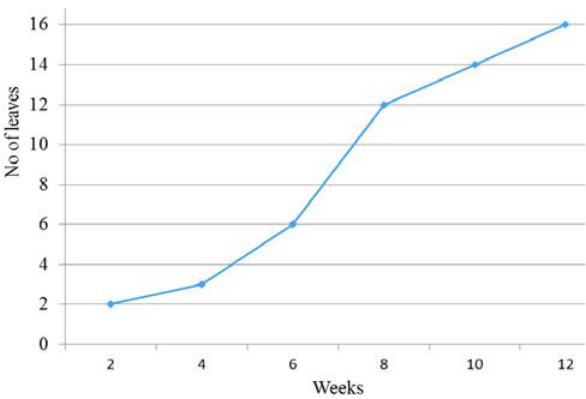
Fig. 2. The number of leaves in fernlets of A. capillus-veneris